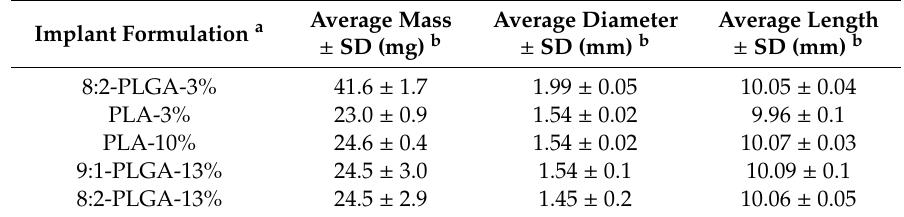
Table 1. Average dimensional measurements of the investigated alendronate sodium (ALN)-loaded implant formulations prepared by hot-melt